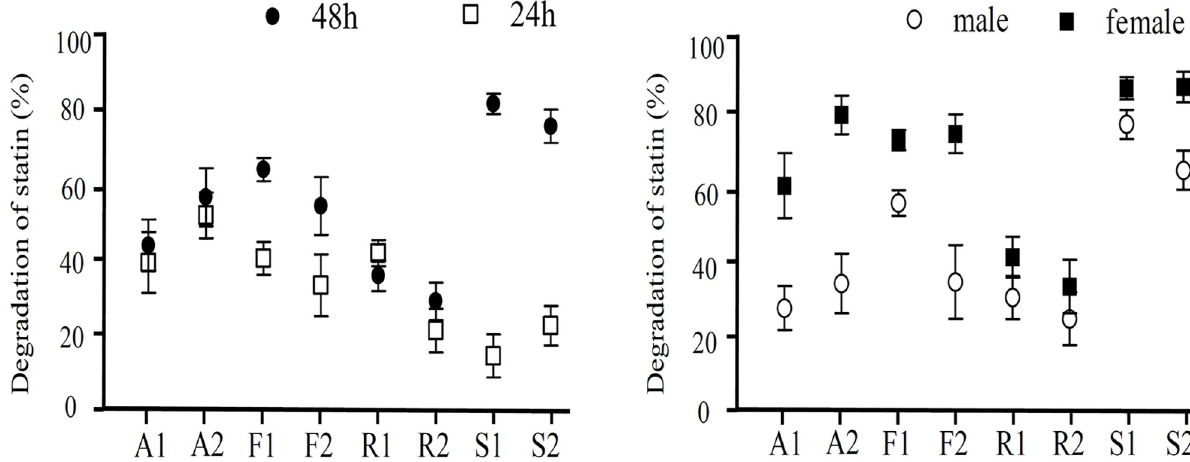
Fig 7. Degradation of statins. Different statins were detected by HPLC, and the degradation was obtained by the original percentage subtracted measurable percentage. Each statin sample was measured in duplicate.